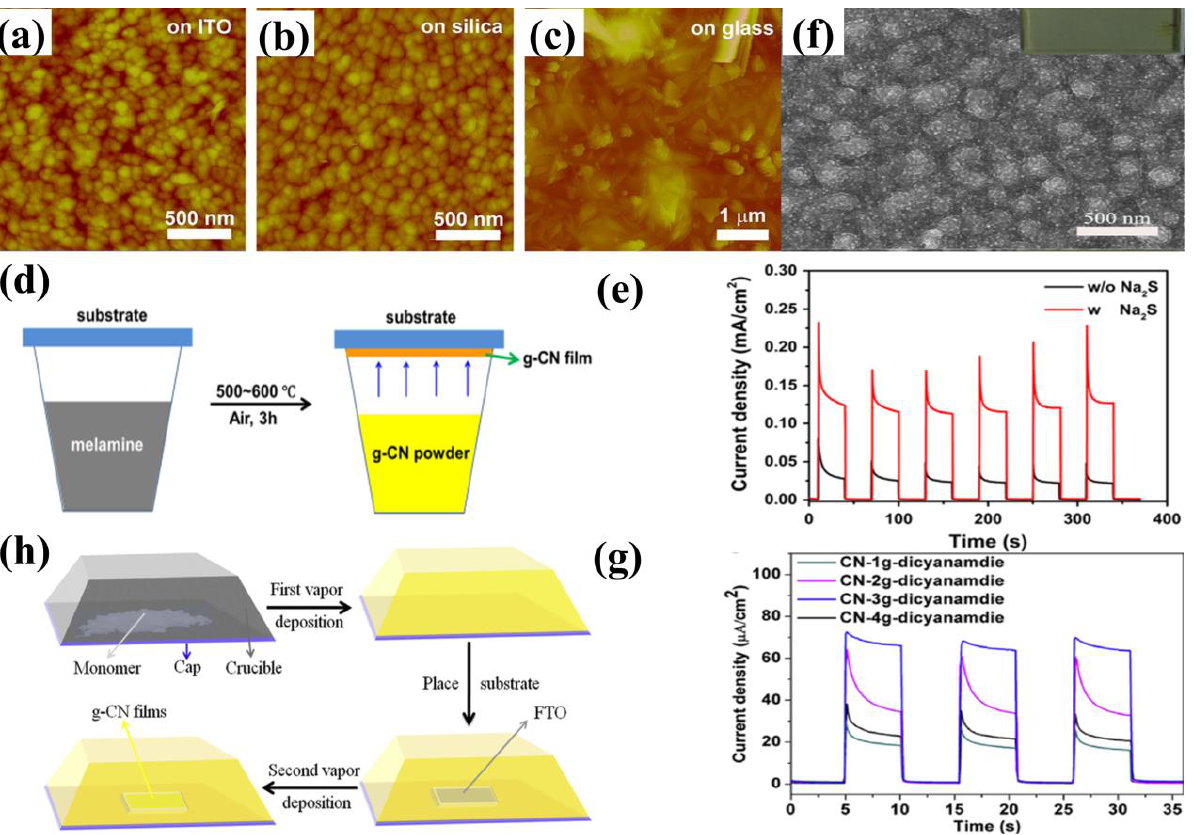
Figure 4. TVC via melamine, illustrating AFM surface morphologies grown on ( a ) ITO glass, ( b ) silica and ( c ) glass, ( d ) TVC growth mechanism, and ( e ) transient photocurrent density of the thin film tested with and without adding Na 2 S at 1.55 V vs. RHE. Reprinted with permission from ref. [48] Copyright 2015 Elsevier. Two-step TVD procedure utilizing dicyanamide: ( f ) SEM images of the g−CN electrodes (the inset is the digital image), ( g ) the corresponding transient photocurrent density in 0.1 M Na 2 SO 4 at 1.23 V vs. RHE, and ( h ) two-step TVC growth mechanism. Reprinted with permission from ref. [49] Copyright 2017